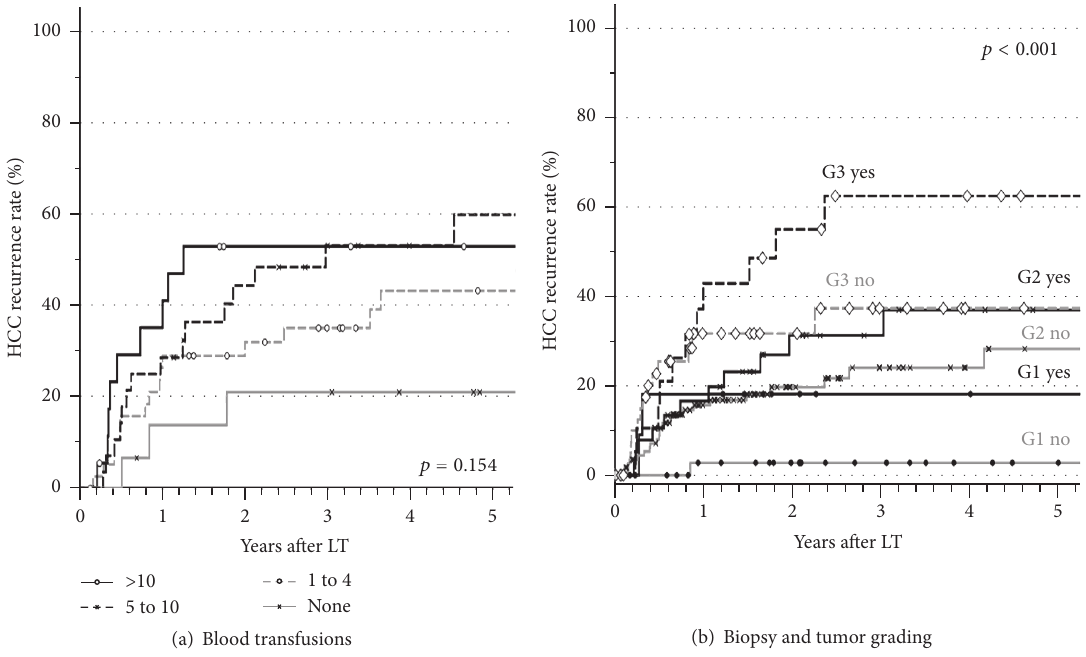
Figure 4: Actuarial HCC recurrence (a) in patients with microvascular invasion in correlation with the number of applied blood transfusions ( 𝑝 =notsignificant)and(b)HCCrecurrenceratesinpatientswith(yes)andwithout(no)tumorbiopsystratifiedfortumorgrading( 𝑝 < 0.001 for biopsy yes versus no stratified for tumor grading G1 to